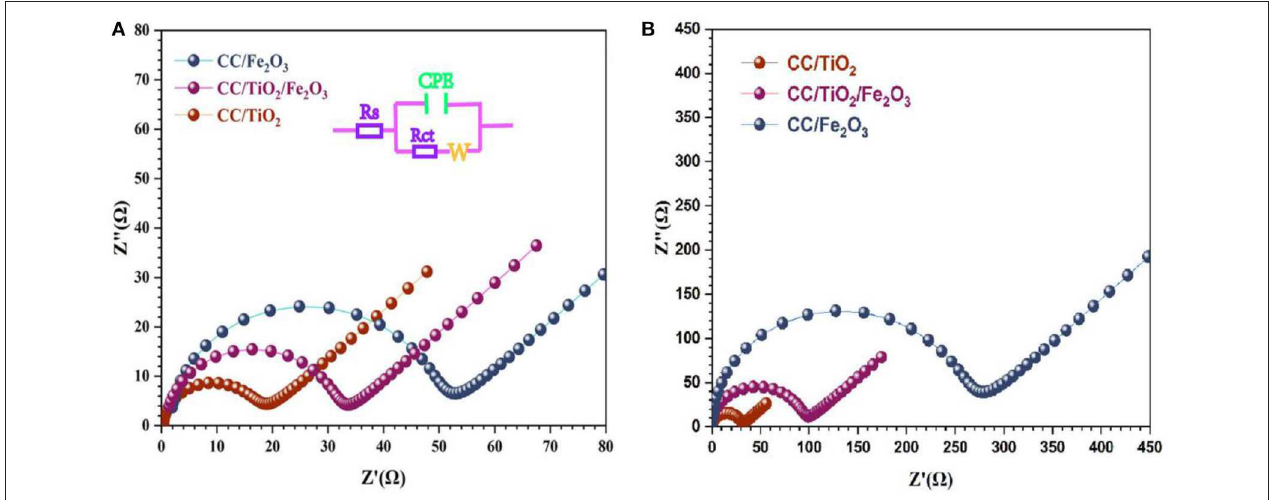
FIGURE 5 | Impedance analysis of CC/TiO 2 /Fe 2 O 3 , s CC/TiO 2 , and CC/Fe 2 O 3 specimens for (A) fresh cell and (B) 50th cycled